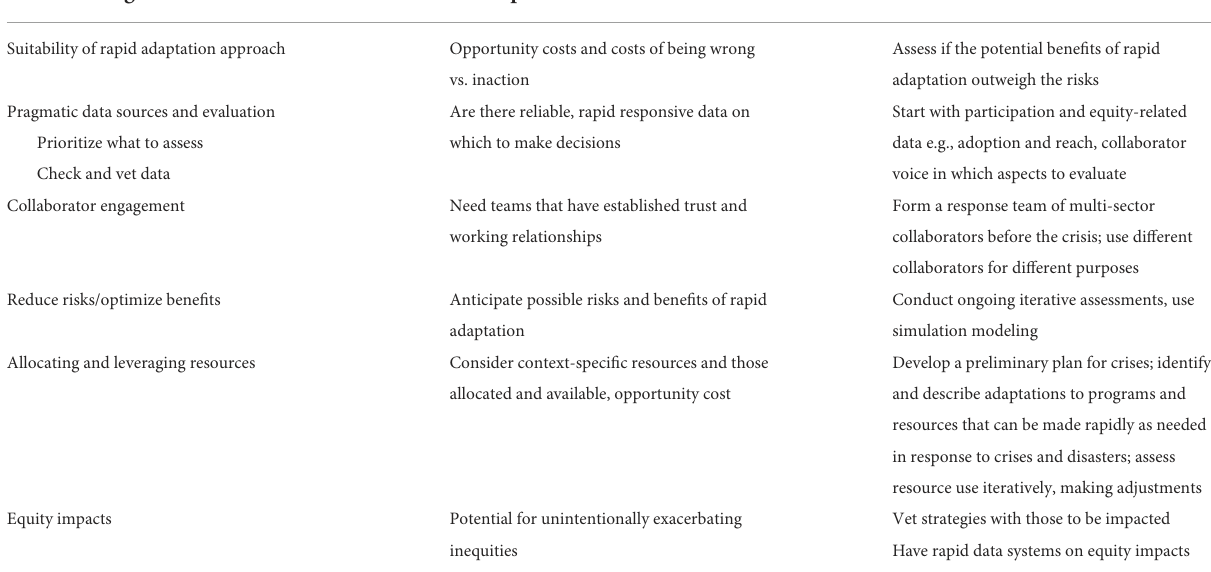
TABLE 1 Cross-cutting issues in rapid